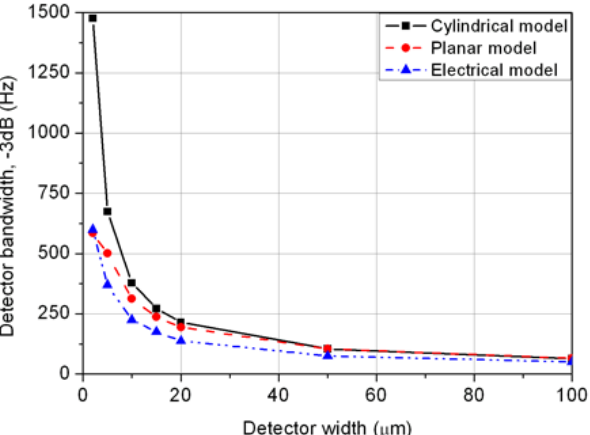
Figure 9. Detector bandwidth at −3 dB obtained with cylindrical, planar and electrical models vs. detector